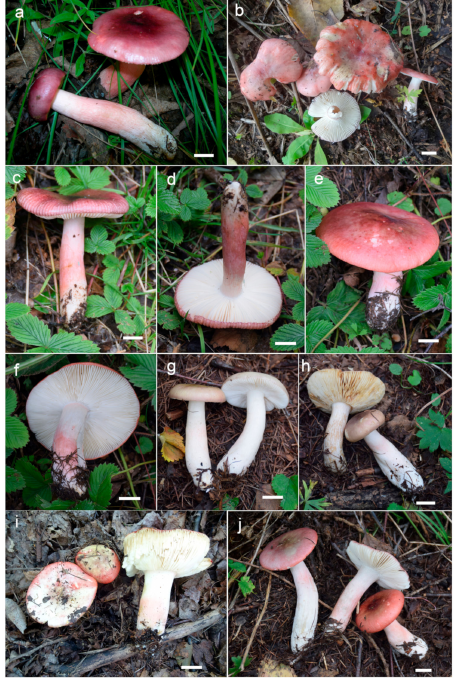
Figure 6. Basidiomata. ( a – d , g , h ) Russula gracillma . ( e , f , i , j ) R. photinia . Bars: 10